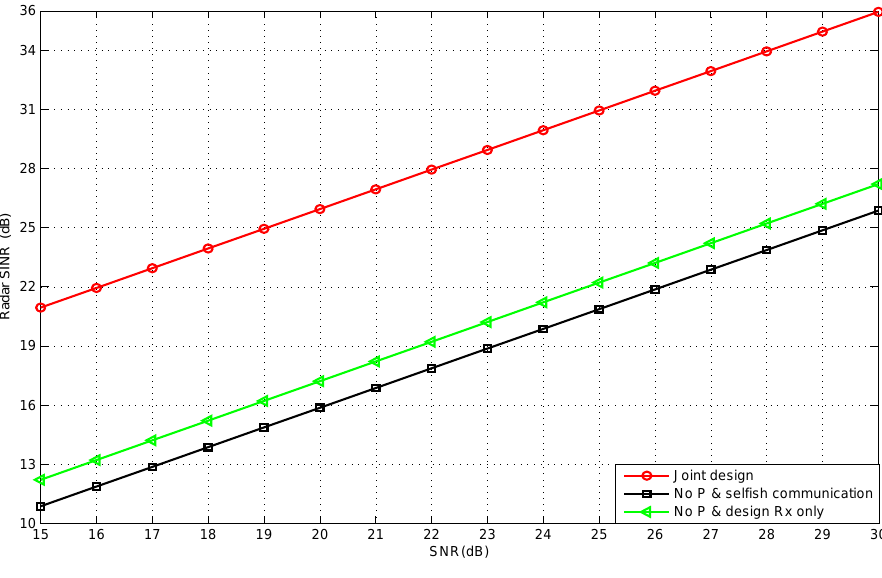
Figure 2. The radar SINR vs. its input SNRs under capacity threshold value 5 bits/s/Hz.